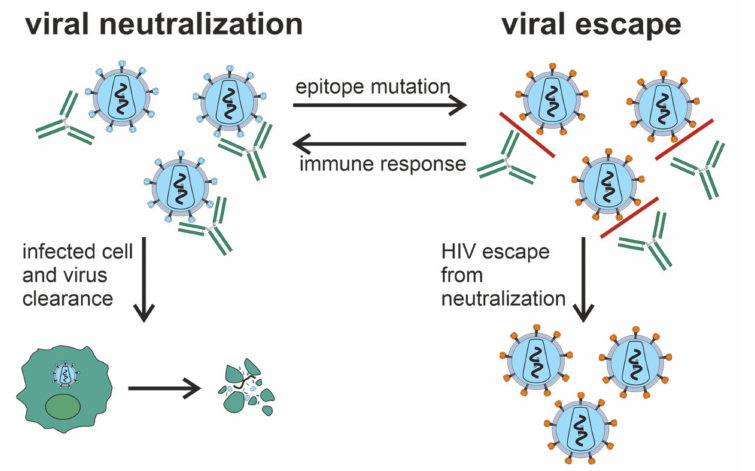
Figure 1. Generation of bNAbs, which neutralize the virus through binding to viral spikes and blocking the entry of the virus into sensitive cells such as CD4 + T cells, is related to the evasion of virus from the immune response due to the low precision of HIV-1 reverse transcriptase and rapid generation of viral mutants. Glycan shield, immunodominant variable loops, and conformational masking of key viral epitopes protect Env from